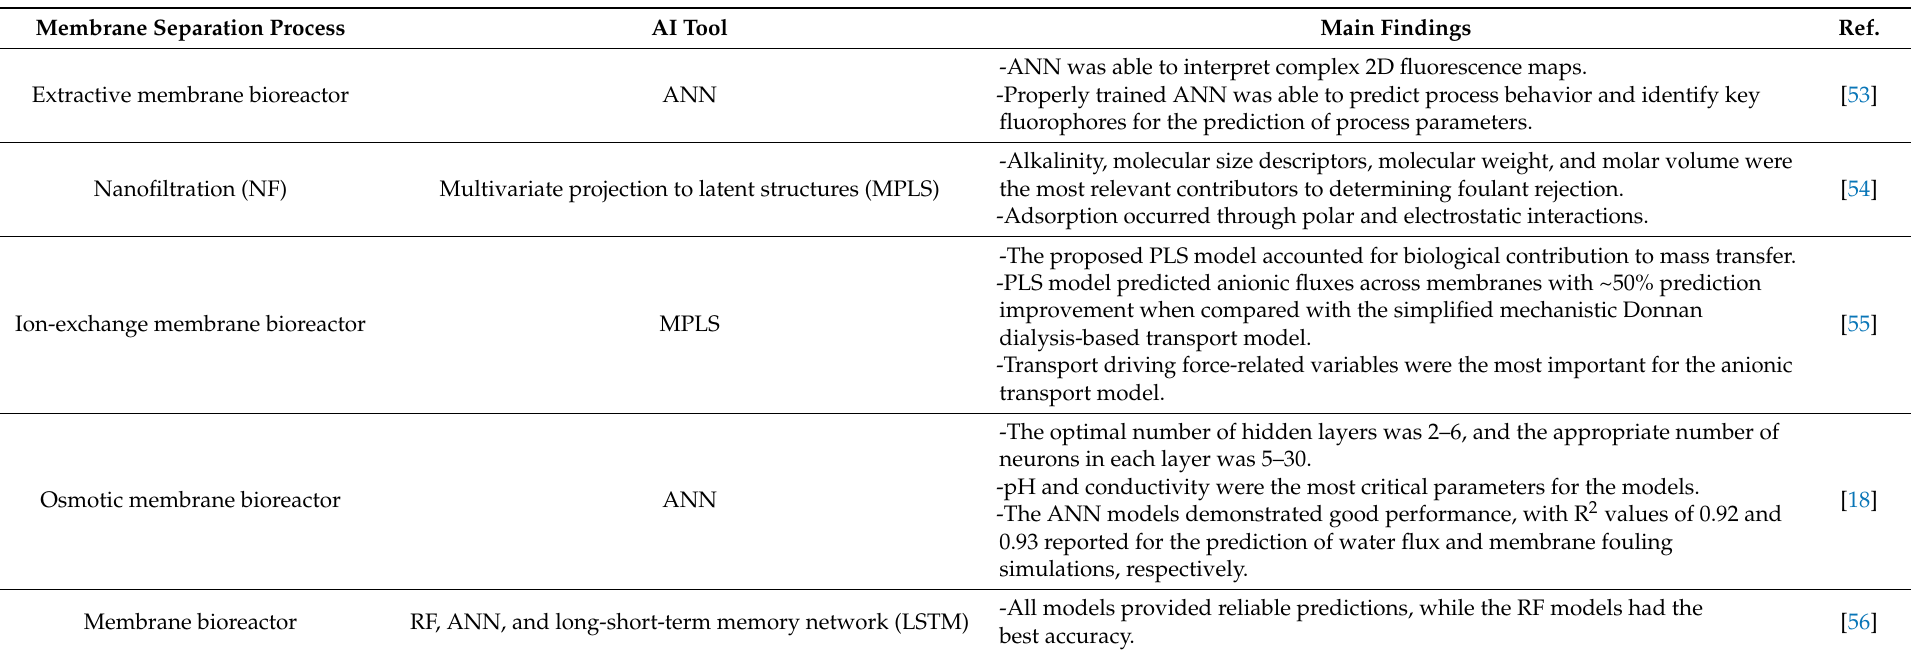
Table 4. Summary of studies that used AI to predict